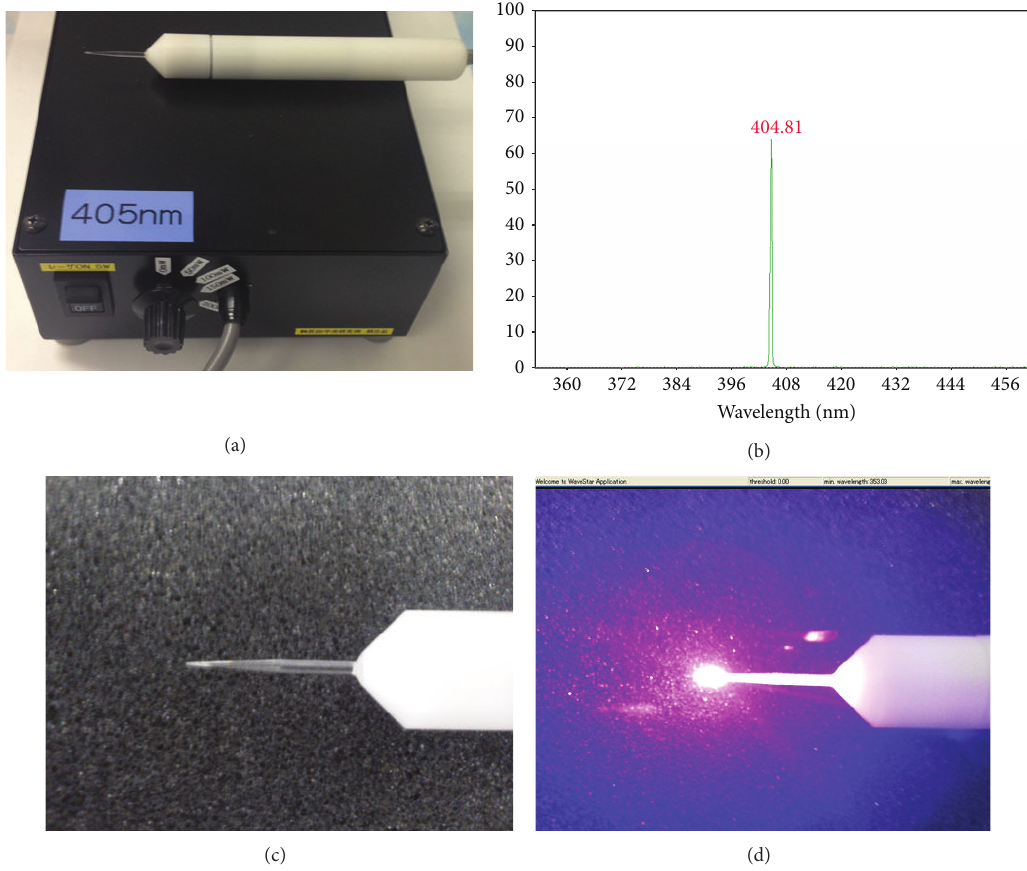
Figure 1: (a) Prototype monochromatic laser-emitting device, with output adjustable between 0.05 W and 0.2 W. (b) Spectrophotometry confirming the monochromatic laser emission at a wavelength of 405 nm. (c) Tapered irradiation tip, made from acrylic resin, with a diameter at the apex of 50 𝜇 m. (d) Emission of 405 nm monochromatic laser light from laser tip.